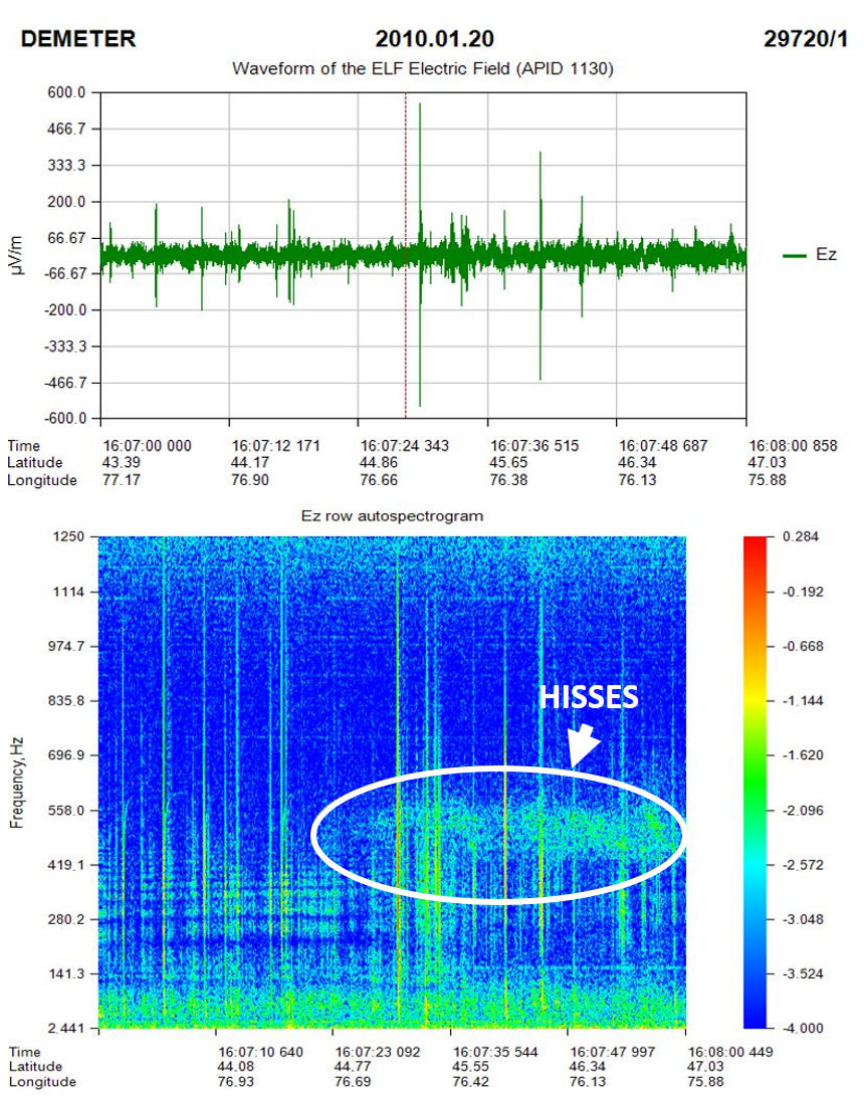
Figure 9. Graph and spectrum of electric field strength in the ELF band for the ascending half orbit no.